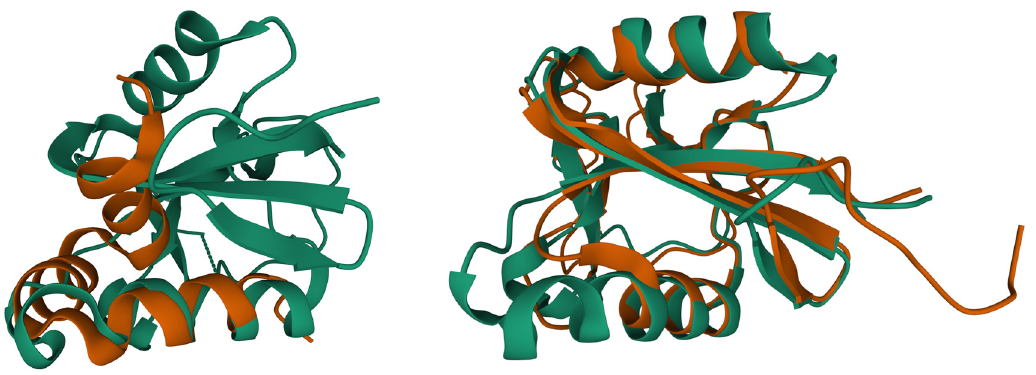
Figure 2. Superposition of biomineralization proteins reveals similarities with the ice binding protein (PDB entry 2zib [49], green color). Superposition of osteocalcin (brown, PDB entry 1q8h [42]) and ice binding protein (left side, rmsd 2.3 Å, 21 C α atoms). Superposition of struthiocalcin (brown, PDB entry 4uww [46]) and ice binding protein (right side, rmsd 1.5 Å, 119 C α atoms). Protein structures are represented as ribbon plot. Superpositions were calculated using the Pairwise Structure Alignment tool of the RCSB PDB server.